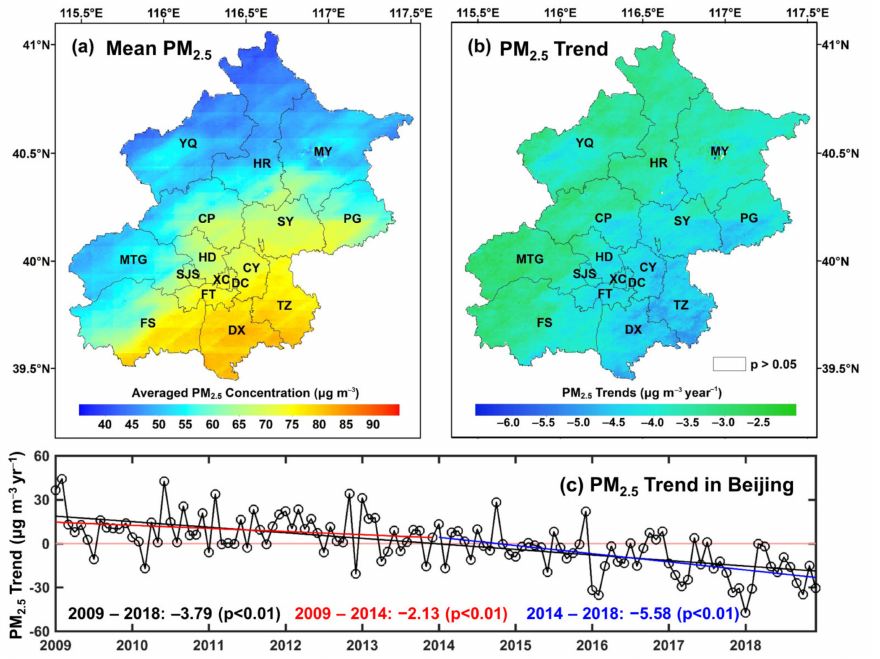
Figure 4. Annual averaged concentrations and trends in PM 2.5 distributions across Beijing from 2009 to 2018. ( a ) is the spatial distribution of annual averaged PM 2.5 ; ( b ) is the spatial distribution of the temporal trends; ( c ) is the overall trend of PM 2.5 concentration in